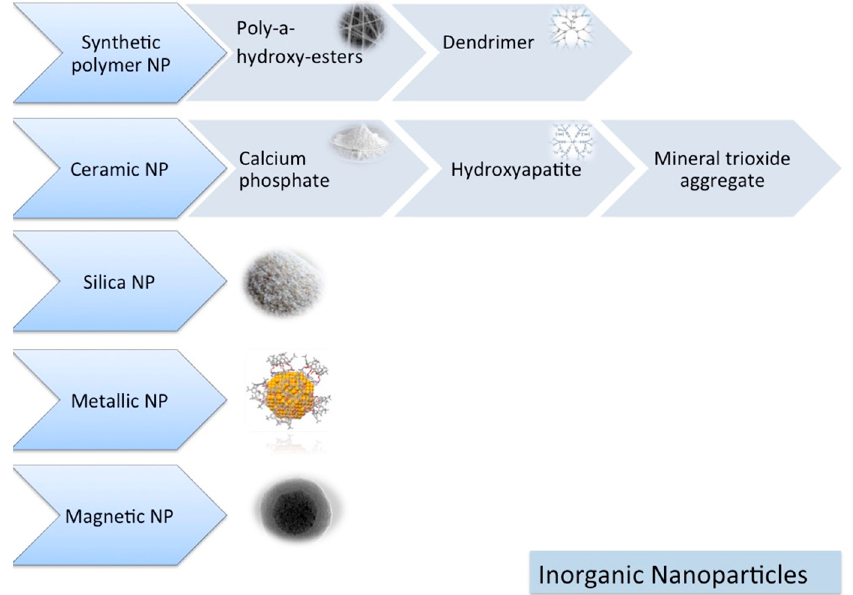
Figure 1. Inorganic nanomaterials.